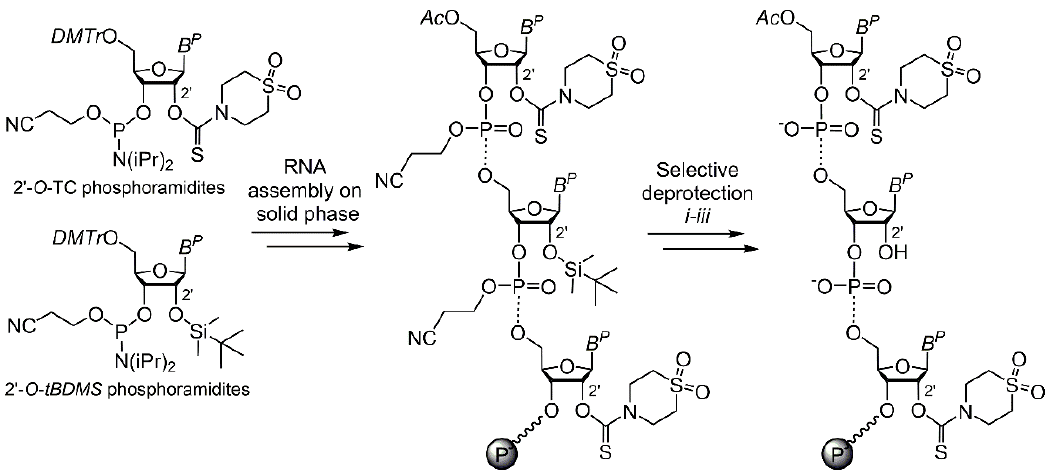
Figure 1. General synthetic strategy for the support-bound 2’- OH /2’- O -TC RNA.